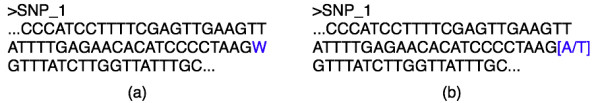
WASP sample input. (a) IUPAC ambiguity code and (b) Bracketing code format